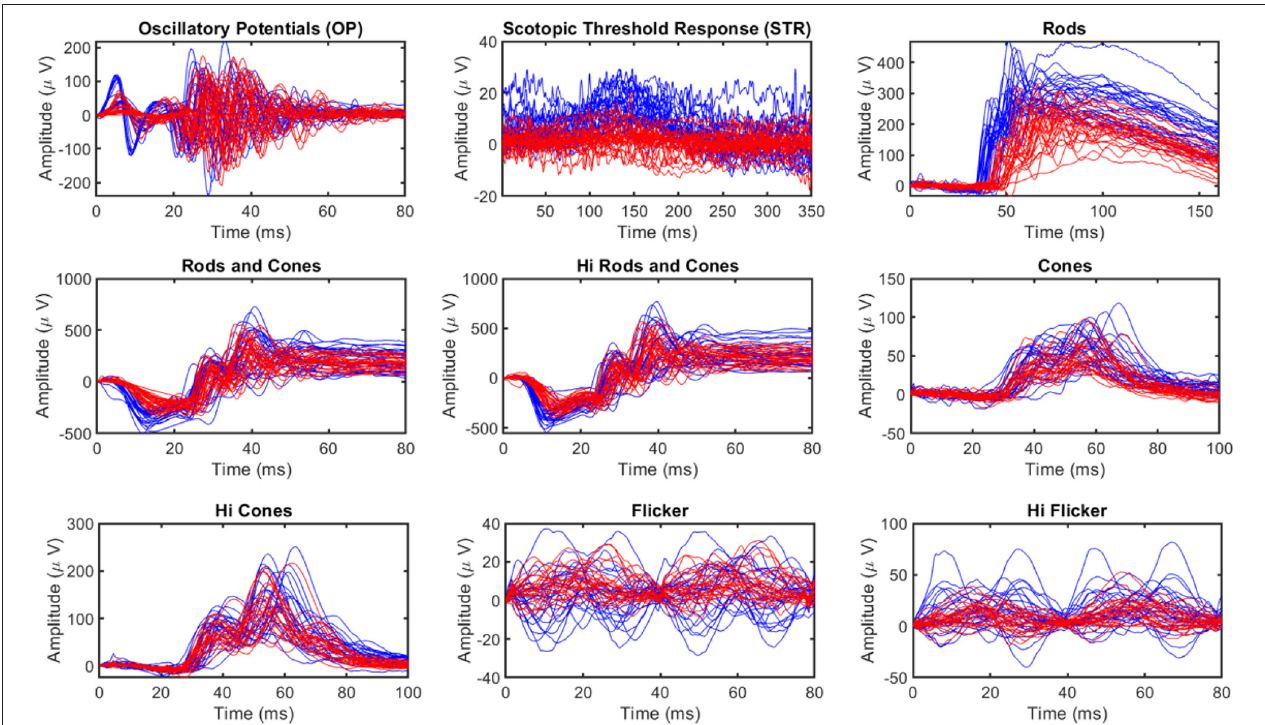
FIGURE 2 | Visualization of ERG Signals manifesting their complex nature. The blue lines correspond to healthy and red lines correspond to glaucomatous Signals. Signals resulting from ERG tests include OP (Oscillatory Potential: small rhythmic wavelets superimposed on the ascending b-wave of the ERG), STR (Scotopic Threshold Response: negative corneal deflection elicited in the fully dark-adapted eye to dim stimuli), Rods (rod response), Rods and cones (standard rod-cone response), Hi Rods and cones (Hi-intensity rods and cones response), Cones (cone response), Hi cones (Hi-intensity cone response), Flicker (Flicker response), and Hi flicker (Hi-intensity flicker